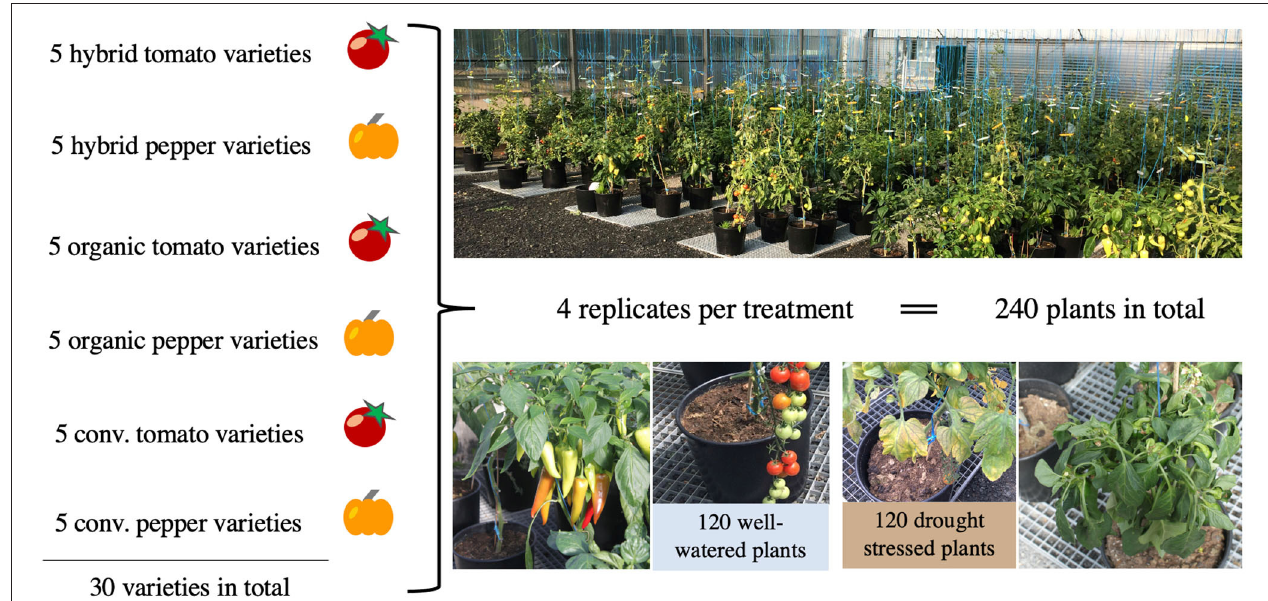
FIGURE 1 | Experimental setup including 15 tomato and 15 sweet pepper varieties. In a randomized block design (above picture) with 4 replicates per treatment the whole experiment contained 120 well-watered plants (60 tomato and 60 sweet pepper plants, left pictures) and 120 drought stressed plants (also 60 tomato and 60 sweet pepper plants, right pictures).